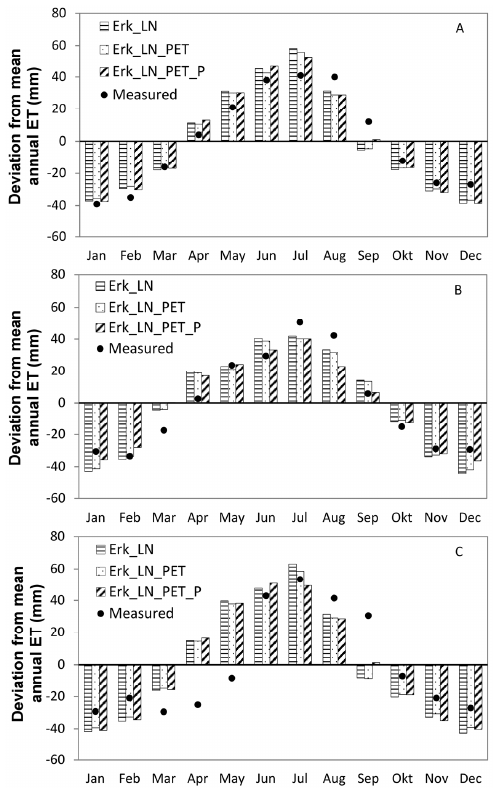
Figure 9. Measured and simulated monthly deviation from mean annual evapotranspiration rates for ( A ) coniferous; ( B ) grassland and ( C ) deciduous vegetation. Measured data refer to (A) eddy-covariance data from [14]; (B) eddy-covariance data from Schmidt (personal communication) and; (C) mean monthly data from a low mountain catchment in northern Germany between 1969 and 1972 with a mean rainfall of 1066 mm [45].